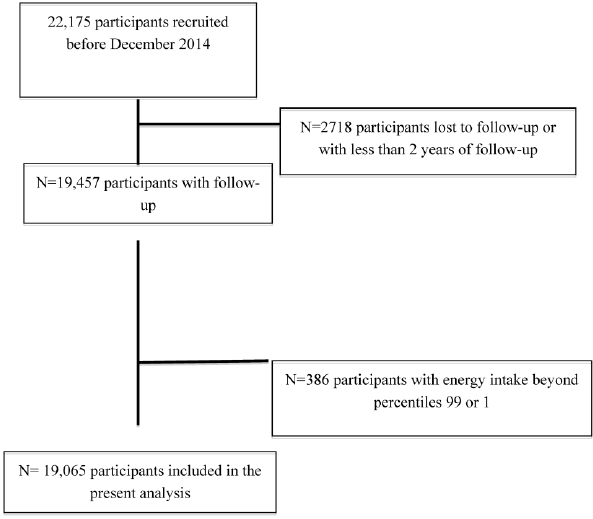
Figure 1. Flow-chart of participants in the SUN Project, 1999–2014.